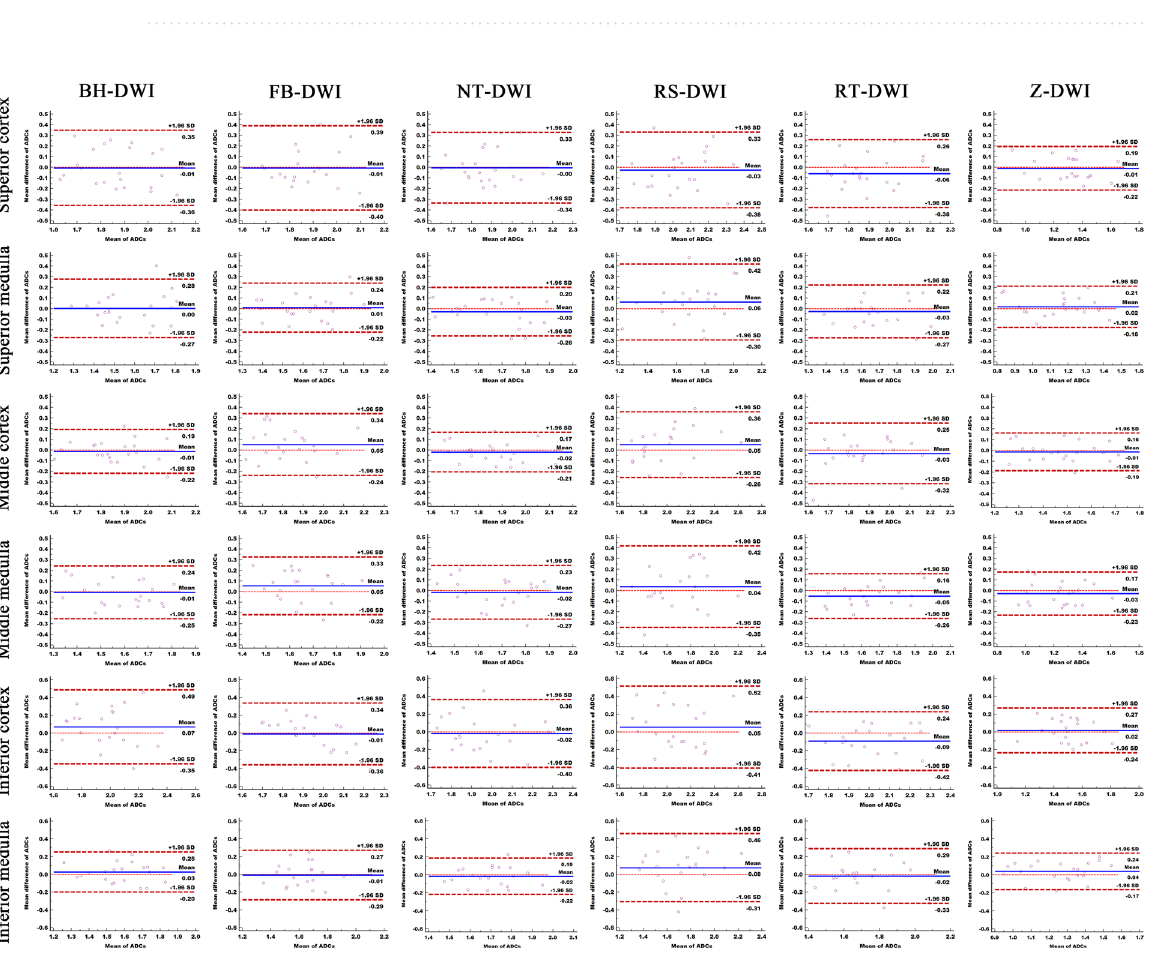
Table 2. The mean absolute differences of ADCs measurement and their 95% confidence interval in twelve anatomic locations with six DWI techniques. The mean absolute differences of ADC Measurement were given in *10 −3 mm 2 /s, which were calculated between the first and second DW imaging series and the differences represented ADC reproducibility. The 95%confidence interval of the mean absolute differences (limits of agreement [LOAs]) were shown in the parentheses. BH-DWI breath-hold DWI, FB-DWI free-breathing DWI, NT-DWI navigator-triggered DWI, RS-DWI readout-segmented DWI, RT-DWI respiratory- triggered DWI and Z-DWI Zoomit DWI.